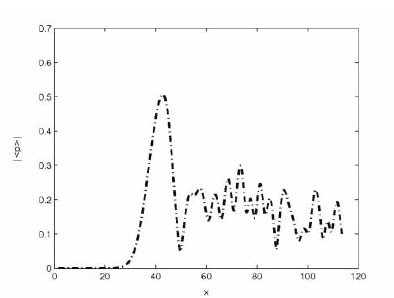
Figure 14. Stationary solution | f | (new), L = 113 . 7, N = 536.